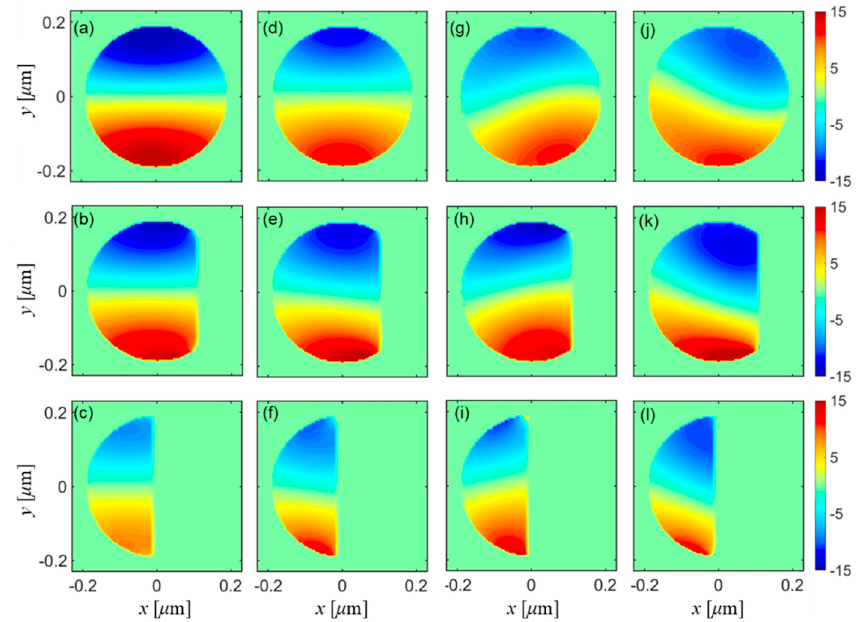
Figure 3. Transverse cross-sectional plots of the optical force-density component F y with varying distances to the oblique fiber endface ( θ = 50°) for different polarizations: the left column corresponds to quasi- x polarized excitation in the central x-y plane with ( a ) z = 4 μ m, ( b ) z = 4.1 μ m, ( c ) z = 4.2 μ m; the second column corresponds to right-circular polarized excitation in the central x-y plane with ( d ) z = 4 μ m, ( e ) z = 4.1 μ m, ( f ) z = 4.2 μ m; the third column corresponds to elliptical polarized excitation with phase retardation of π /4 in the central x-y plane with ( g ) z = 4 μ m, ( h ) z = 4.1 μ m, ( i ) z = 4.2 μ m; the fourth column corresponds to elliptical polarized excitation with phase retardation of 3 π /4 in the central xy plane with ( j ) z = 4 μ m, ( k ) z = 4.1 μ m, ( l ) z = 4.2 μ m. The color scale bar shows the force density in units of N/(m 3 ·nW).